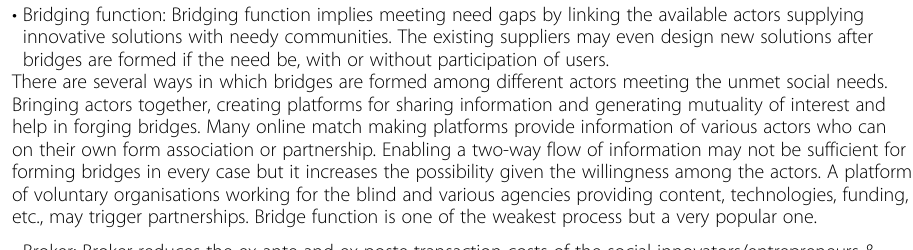
Table 3 Taxonomy of social innovation approaches (six Bs of basic design approaches)